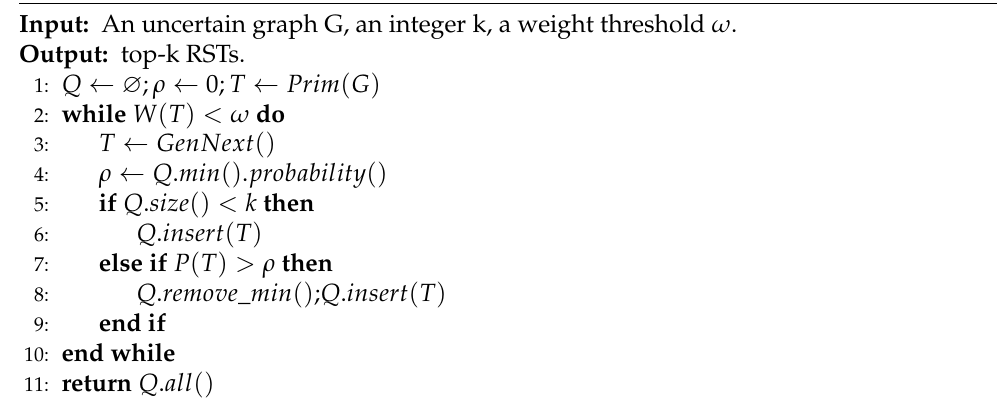
Algorithm 1. The KMST tree-filtering algorithm,